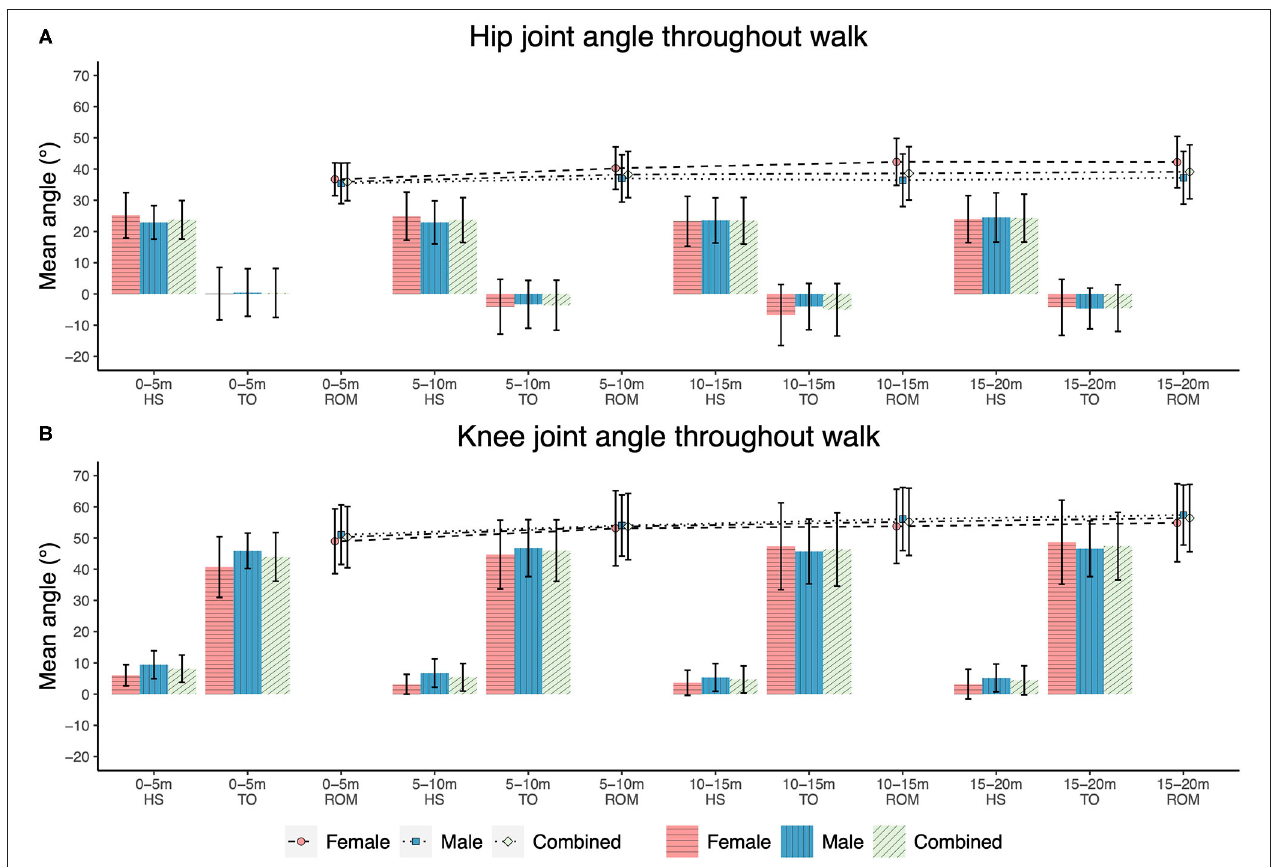
FIGURE 5 | Joint ROM kinematic measures for each 5m interval of the 20m yoke walk. (A) hip joint kinematics; (B) knee joint